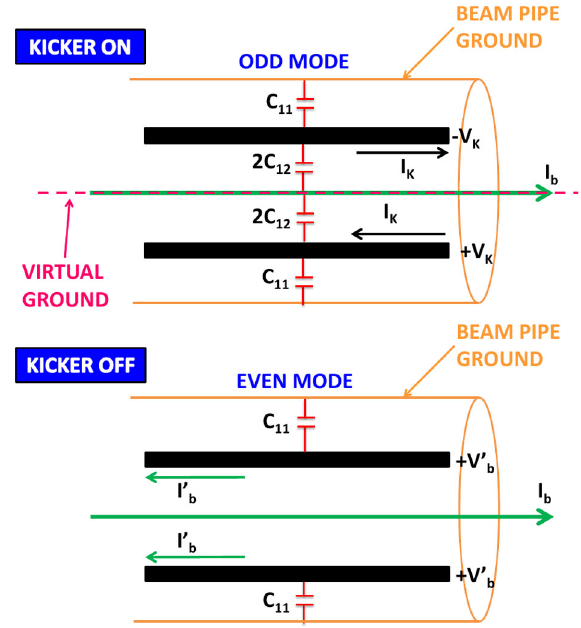
FIG. 2. Scheme of the two operation modes of a pair of coupled electrodes: odd mode (top) and even mode (bottom). For the even mode, I 0 b and V 0 b correspondstotheimagecurrentandvoltagecreated by the beam when passing through the aperture of the